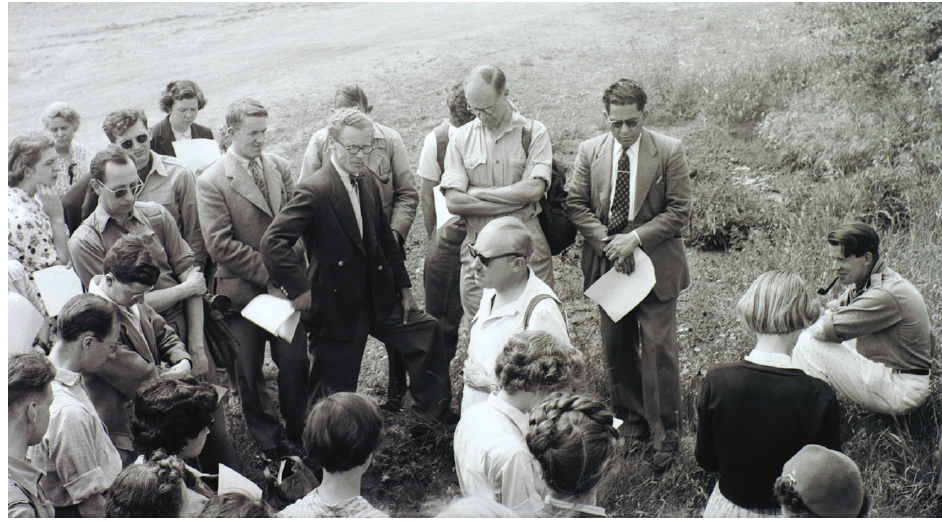
Fig. 2: Charles Thomas (seated right, with pipe) listening to Zeuner (centre, with sunglasses) addressing a field excursion on site at Swanscombe, Kent, in